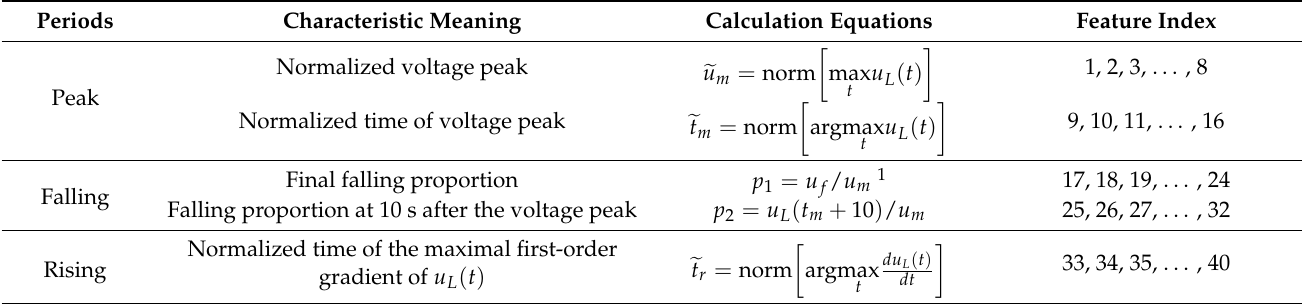
Table 2. The statistics used as features for classification.